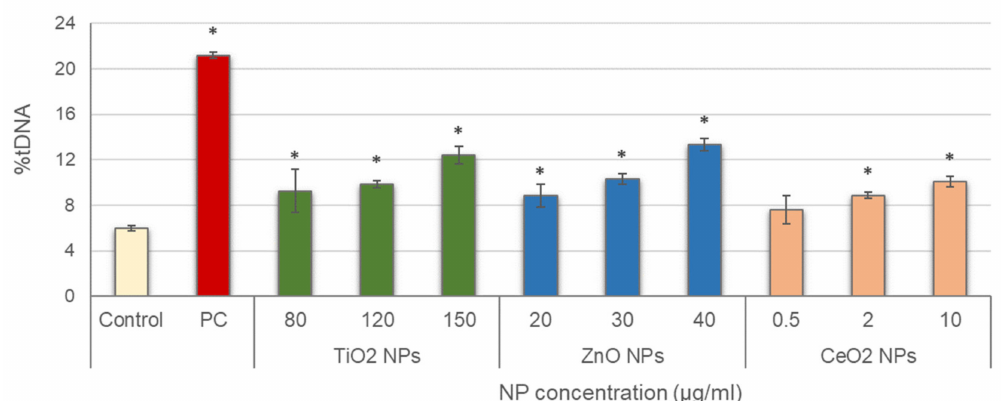
Figure 2. Results of primary DNA damage induced in salivary leucocytes exposed to TiO 2 , ZnO and CeO 2 NPs. PC: positive control (50 µ g/mL MMS for 3 h). Columns represent mean values and error bars indicate the standard errors. * p < 0.01, significant difference with regard to the negative control.